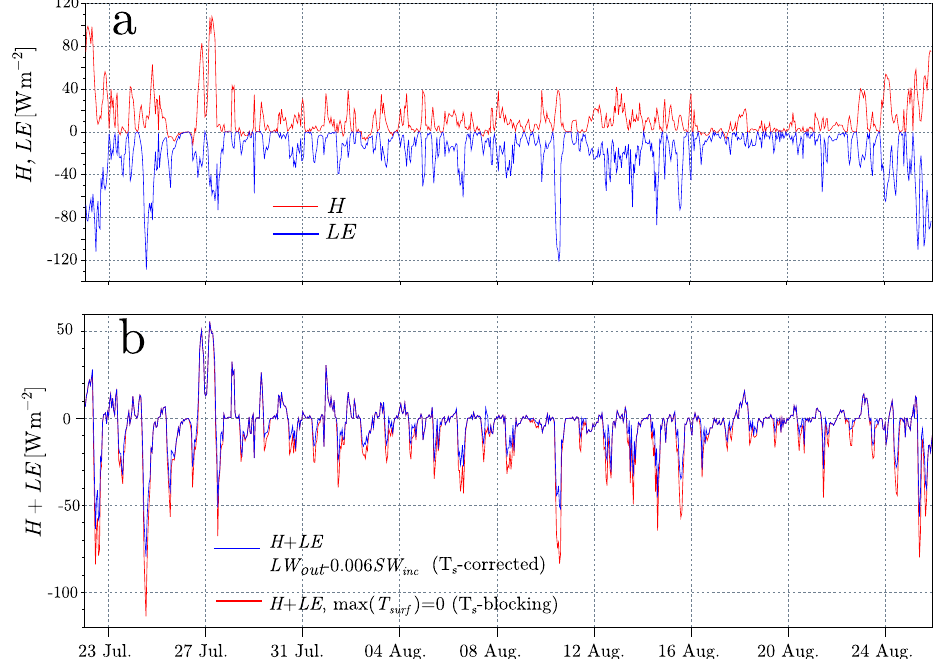
Figure 9. Turbulent fluxes derived from the bulk-aerodynamic method for the fifth measurement level on the profile mast ( ∼ 2 . 08m) with different surface-temperature derivation methods over the entire campaign. (a) Time series of fluxes H and LE estimated from surface temperature derived from LW out measurements corrected with the “ T s -blocking” method. (b) Net turbulent flux estimated with surface temperature corrected with “ T s -blocking” (red) and “ T s -corrected” (blue) methods (Sect.